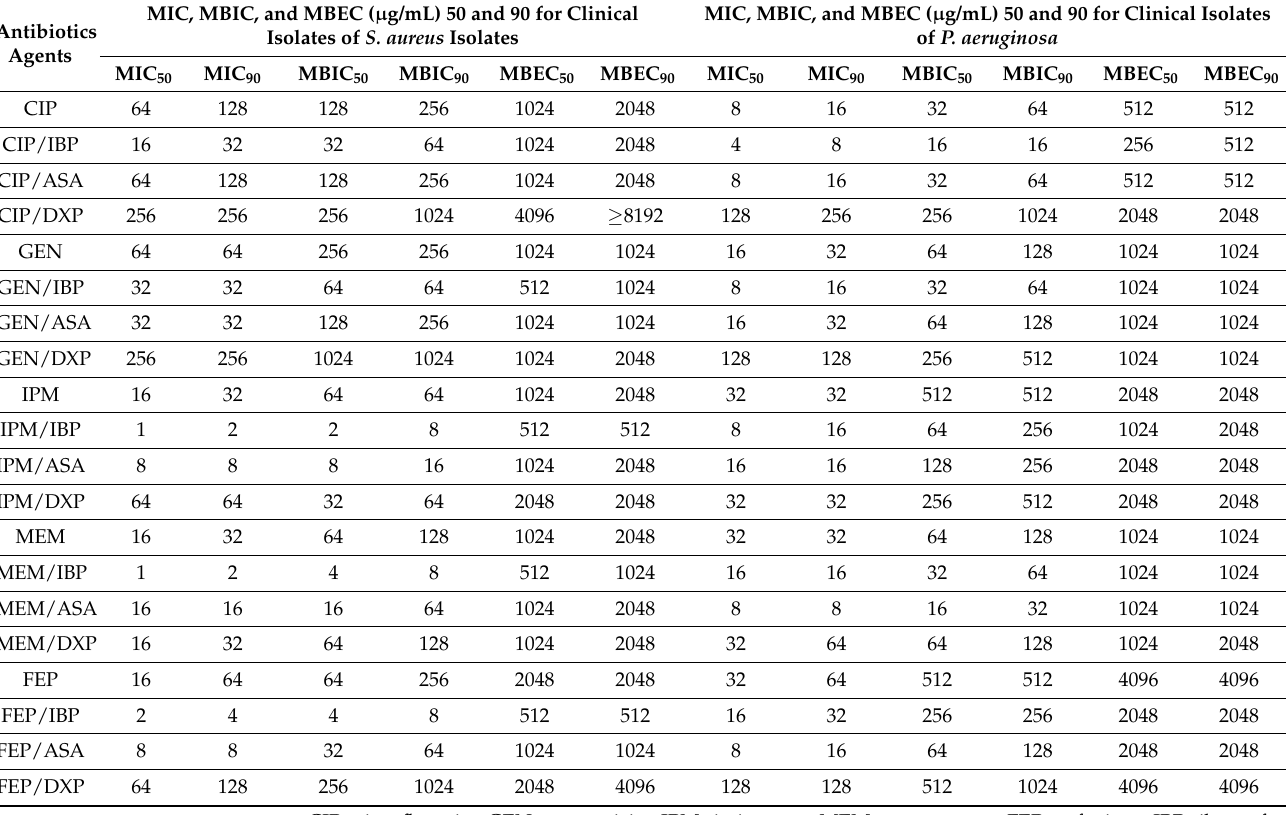
Table 2. Distribution of MIC, MBIC, and MBEC 50 and 90 in clinical isolates of S. aureus and P. aeruginosa with and without sub-MICs of anti-inflammatory